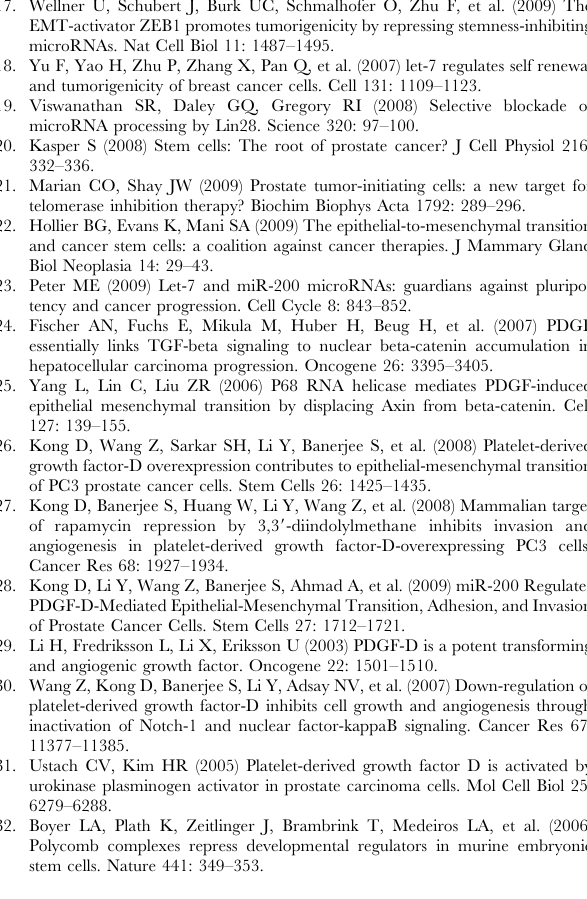
Figure S3 Binding sites of miR-200b and miR-200c in 3 9 UTR of Lin28B or Bmi1 mRNA. Conserved, predicted binding sites for the seed sequences of miR-200b and mir-200c in the 3 9 UTR of Lin28B or Bmi1 mRNA were shown. Figure S4 Let-7 regulated the self-renewal of PC3 PDGF-D. (A) Transfection of pre-let-7 or combination of pre-let-7 and Lin28B siRNA reduced the size of prostaspheres. (B) Transfection of pre- let-7 or combination of pre-let-7 and Lin28B siRNA increased the numbers of prostaspheres with smaller size (30–50 m m) and reduced the number of prostaspheres with bigger size ( . 100 m m) compared to transfection with control. **, p , 0.01